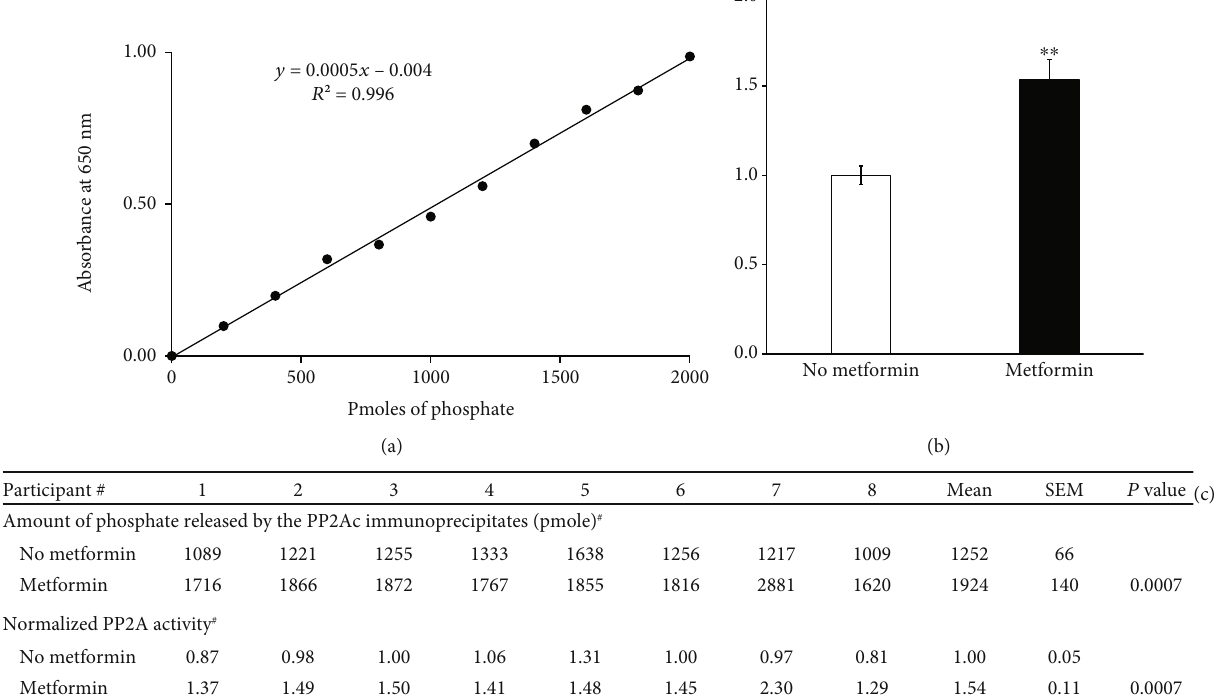
Figure 1: E ff ect of metformin on PP2A activity in primary human muscle cells derived from 8 lean insulin-sensitive nondiabetic participants ( n = 8 ). (a) Measurement of phosphate concentration of the standard solutions (according to the manufacturer ’ s protocol). (b) Summative PP2A activity. Data are given as fold changes ( means ± SEM ). The mean of the PP2A activity for the 8 samples without metformin treatment was set to 1.00, and the fold changes were relative to basal (i.e., no metformin treatment). (c) Individual PP2A activity. The signi fi cance between the basal and metformin-treated groups was analyzed by independent Student ’ s t -test. ∗∗ P < 0 : 001 . # Amount of phosphate released re fl ects the PP2A activity, and the mean of the PP2A activity for the 8 samples without metformin treatment was set to